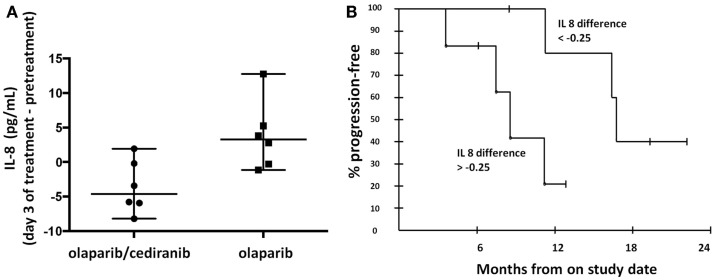
Proangiogenic cytokines. (A) Patients on olaparib/cediranib had a greater change in circulating IL-8 concentration with treatment than patients on olaparib alone (p = 0.026). (B) Patients with greater IL-8 change [below the median IL-8 difference (−0.25)] was associated with longer PFS (p = 0.028). The 6-month PFS probability for the six patients with changes above the median was 83.3% (95% CI 43.6–97.0), while for the group with the changes below the median, it was 100% (95% CI 54.1–100). At 12 months, the respective probabilities of PFS were 20.8% (95% CI 3.8–63.6) and 80.0% (95% CI 37.6–96.4).